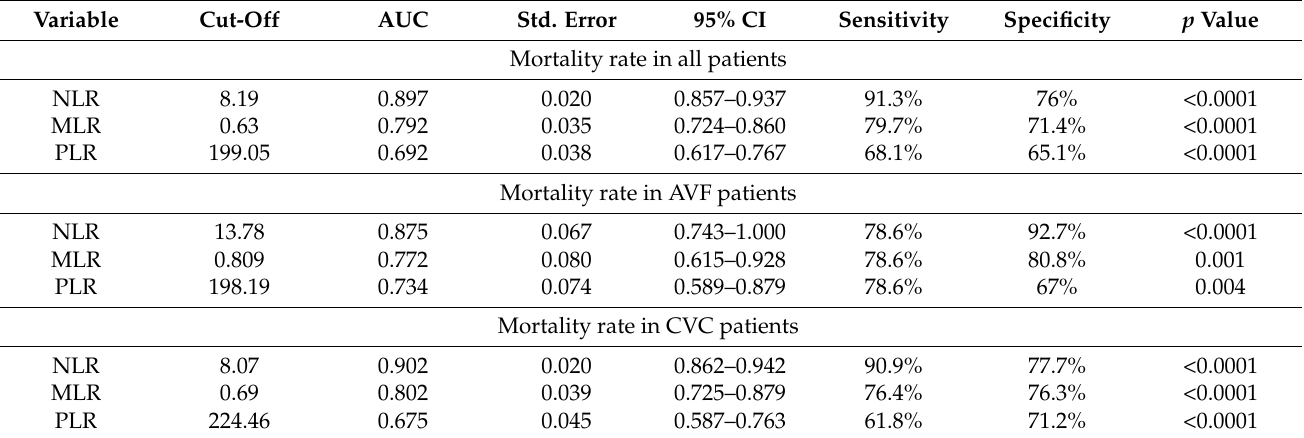
Table 4. ROC curves, optimal Cut-Off value, AUC, and predictive accuracy of inflammatory markers NLR, MLR, and PLR.